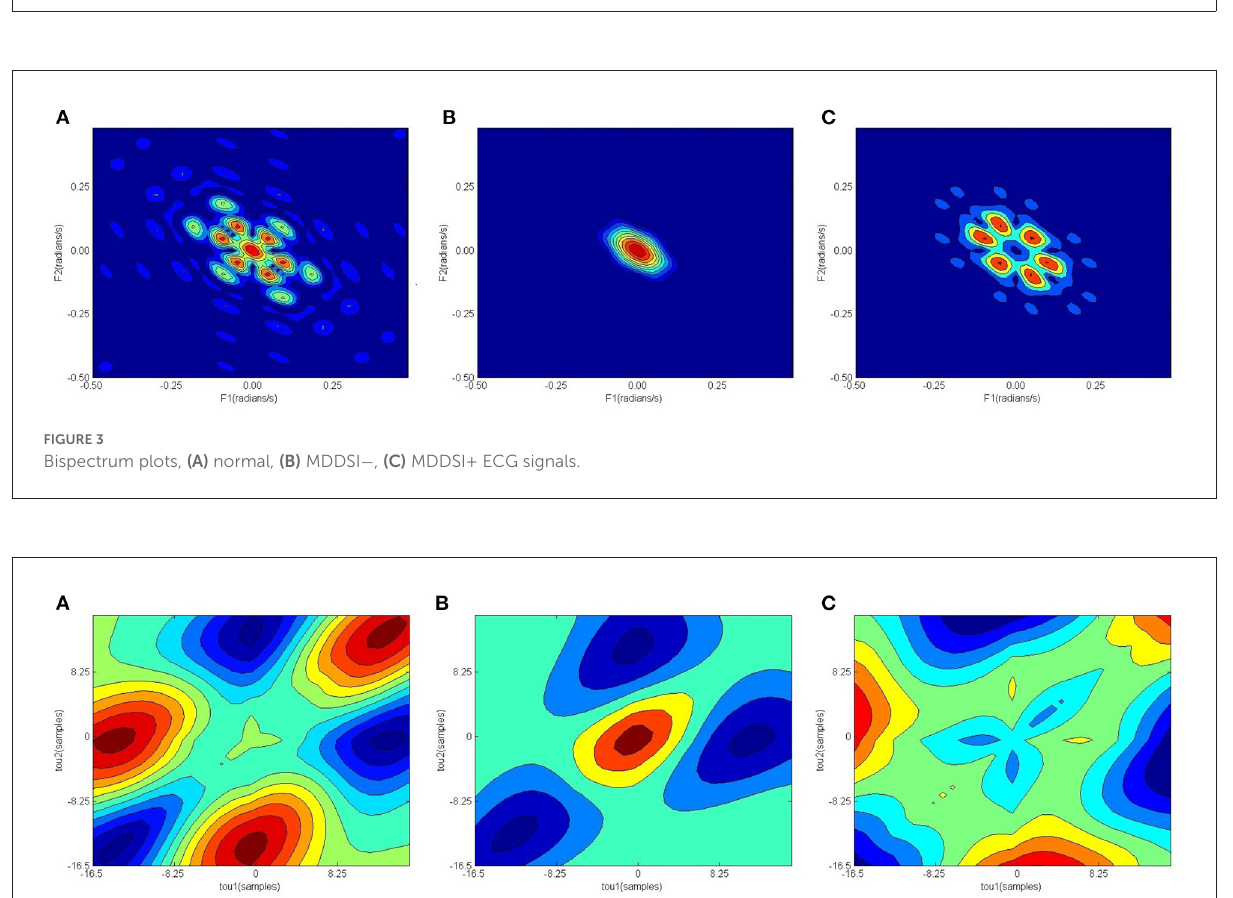
FIGURE2 The results of (A) confusion matrix, and (B) ROC curve, correspond to the best reported results obtained using the SVM-RBF classifier, highlighted in Table 4.